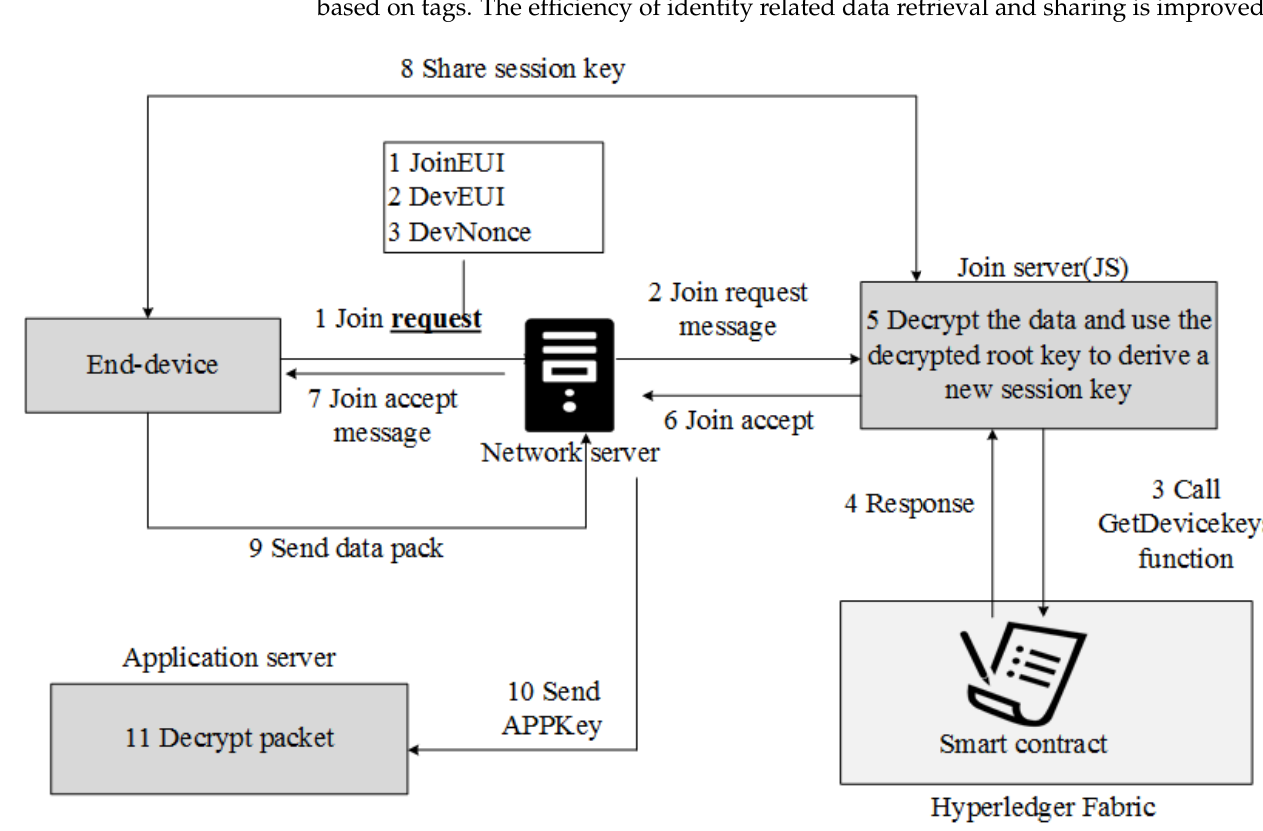
Figure 9. Reconstruction diagram of reference [30].